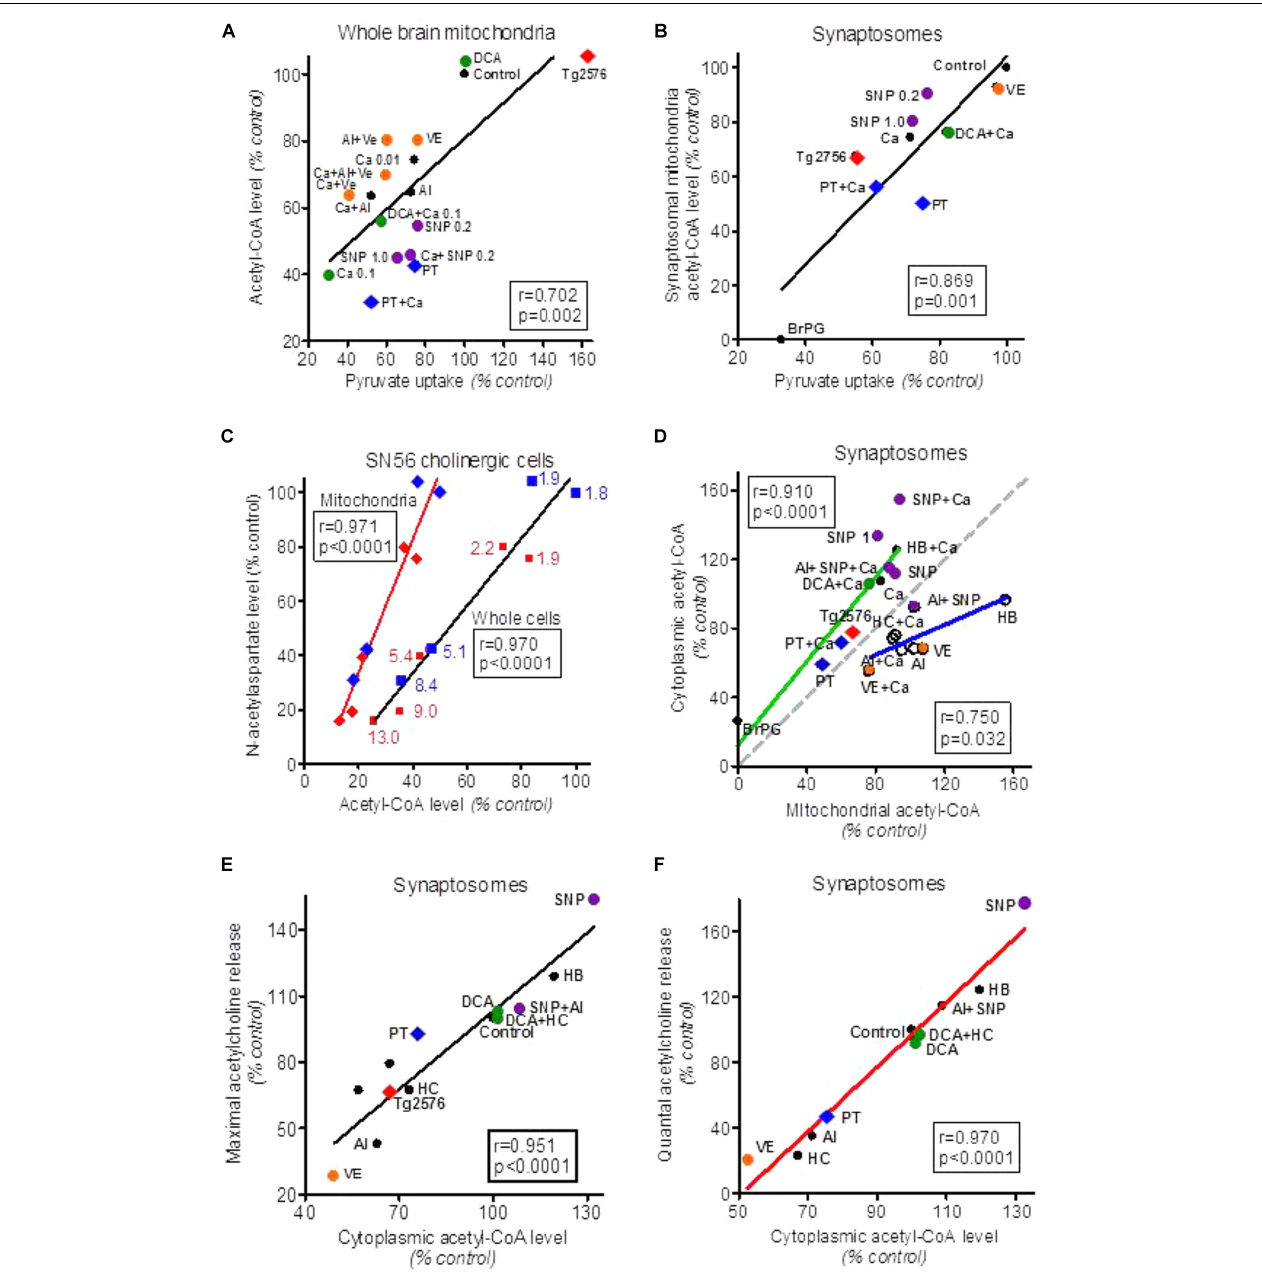
FIGURE 1 | Alterations of acetyl-CoA levels in forebrain cellular compartments in different experimental models of neurotoxicity and neurodegeneration. (A) Effects of variations in pyruvate uptake on acetyl-CoA level in whole brain (predominately glial) mitochondria treated with different cytotoxic and cytoprotective compounds. (B) Effects of alterations in pyruvate uptake by isolated brain synaptosomes on acetyl-CoA level in their mitochondria. (C) Effects of Zn overload of SN56 non-differentiated (blue) and differentiated (red) cholinergic neuroblastoma cells (blue and red numbers indicate intracellular Zn in nmol/mg protein) on acetyl-CoA level in whole cells and cell’s mitochondria and their N -acetylaspartate content. (D) Correlations between cytoplasmic and mitochondrial acetyl-CoA levels in synaptosomes treated with cytotoxic/cytoprotective agents increasing (green plot) or decreasing/not affecting mitochondrial membrane permeability (blue plot). The gray dotted line corresponds to theoretical stoichiometric compartmentalization of acetyl-CoA. (E) Effect of alterations in synaptoplasmic acetyl-CoA level on maximal Ca ++ /K + depolarization-evoked acetylcholine release/synthesis in synaptosomes treated with different cytotoxic and cytoprotective compounds. (F) Effect of alterations in synaptoplasmic acetyl-CoA level on Ca-dependent (quantal) acetylcholine release by synaptosomes treated with different cytotoxic and cytoprotective compounds. Al, aluminum 0.25 mmol/L; BrP, 3-bromopyruvate 0.25 mmol/L; Ca, Calcium 0.01 and 0.1 with mitochondria, Ca 1.0 mmol/L with synaptosomes; DCA, dichoroacetate 0.05 mmol/L; HB, β -hydroxybutyrate 20 mmol/L; HC, (–) hydroxycitrate 1.0 mmol/L; PT, pyrythiamin-thiamin deficient synaptosomes; SNP, sodium nitroprusside 0.2 and 1.0 mmol/L; Tg2576, transgenic AD mice; VE, verapamil 0.1 mmol/L. Data were recalculated to relative values from original data: Bielarczyk and Szutowicz (1989), Szutowicz et al. (1994a, 1998a), Tomaszewicz et al. (1997), Bielarczyk et al. (1998, 2015), Jankowska-Kulawy et al. (2010), Zy´sk et al. (2017).